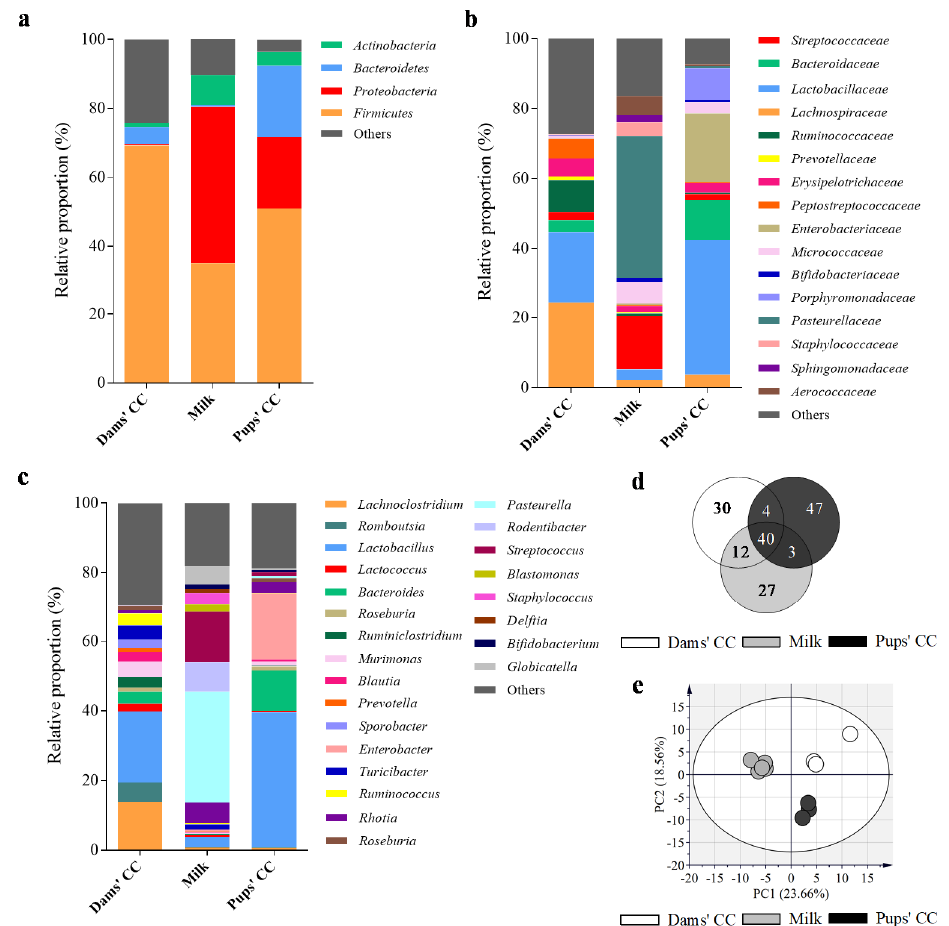
Figure 4. Assessment of microbiota composition of milk ( n = 6) and CC ( n = 3). The sequencing of the amplicon targeting the V3–V4 region of the 16S rRNA was performed following the 16S Metagenomic Sequencing Library Illumina 15044223 B protocol. The main taxonomic ranks abundances, corresponding to ( a ) phylum, ( b ) family, and ( c ) genera are represented in stacked bars. The qualitative assessment of microbiota was represented ( d ) in a Venn Diagram at the level of genera. Finally, the natural clustering of samples was assessed ( e ) by Principal Component Analysis (PCA) at the level of genera. Results derived from n = 5 for milk and n = 3 for both dams’ and pups’ CC. Cecal content (CC).